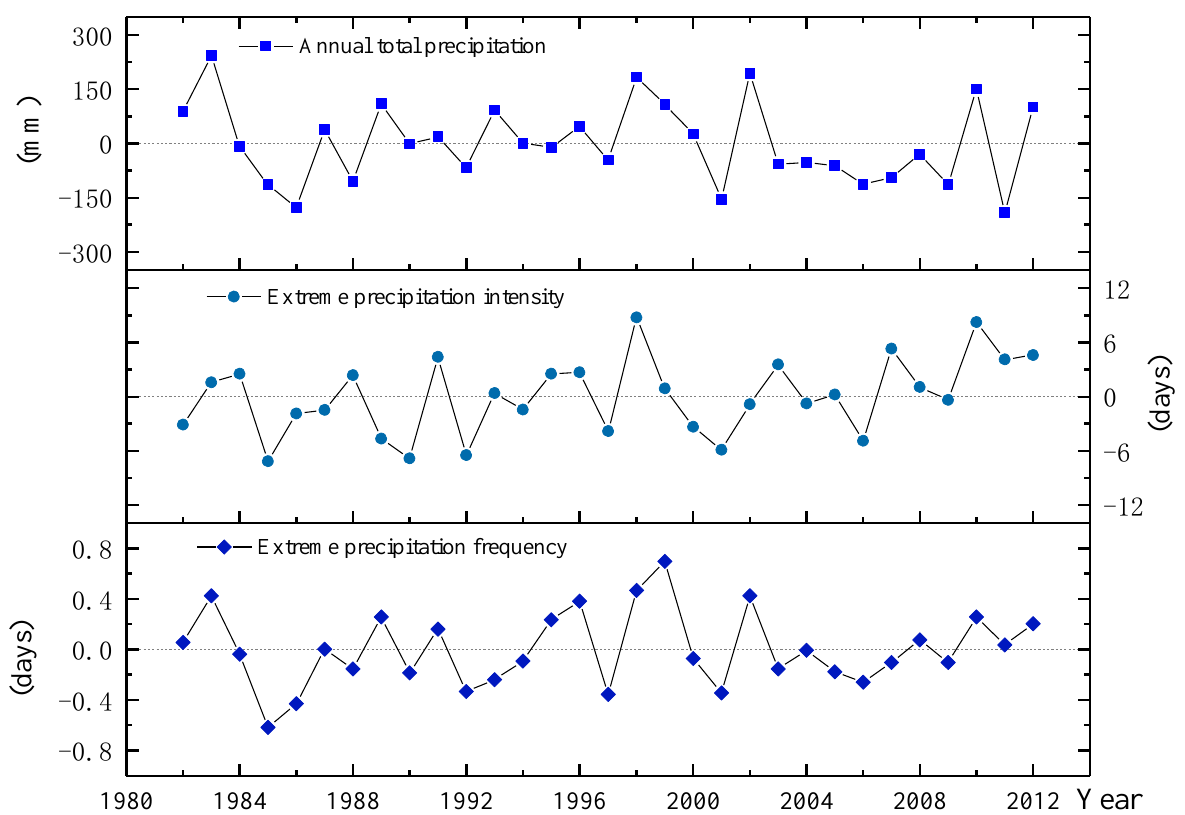
Figure 2. Temporal variations in the intensity and the frequency of extreme precipitation events in the MLR-YR from 1982 to 2012.